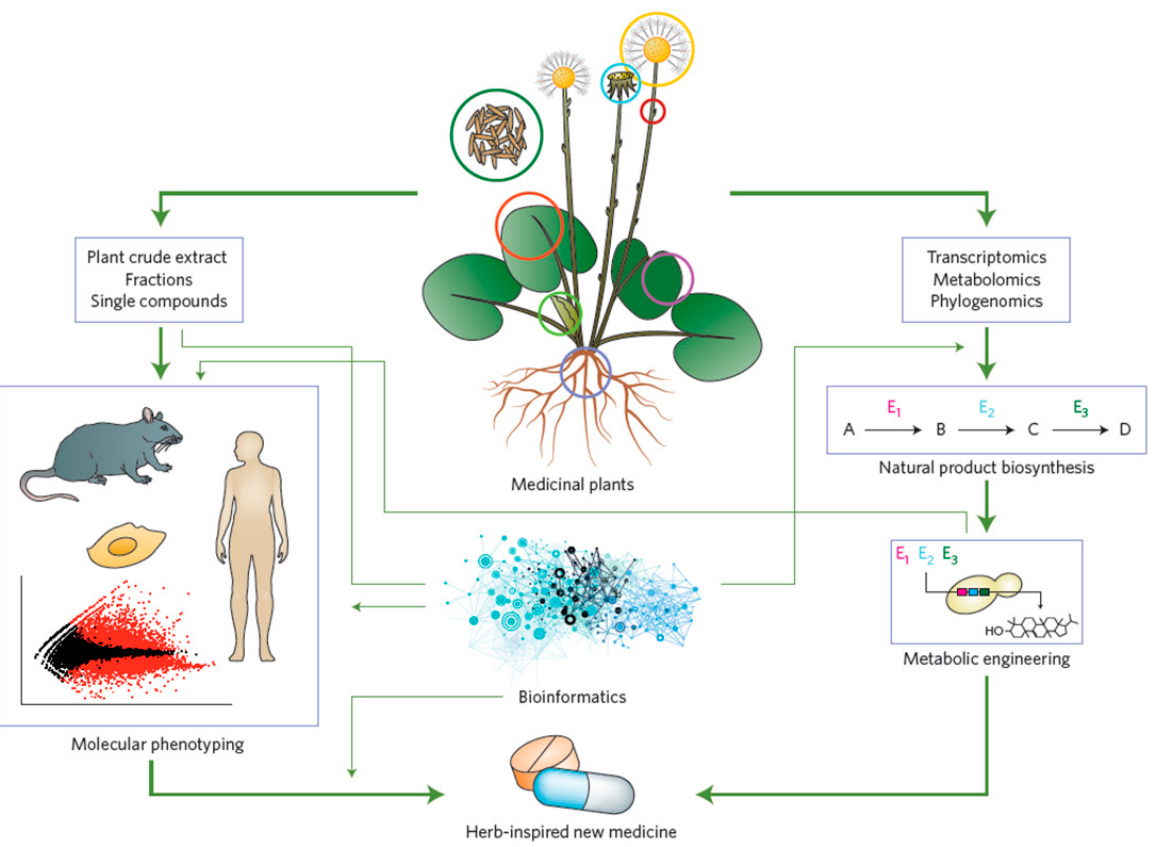
Figure 1. Technological advances in the fields of medicinal properties of plants in the post-omics era for developing new medicine to aid future drug development. Reproduced with permission from [1].